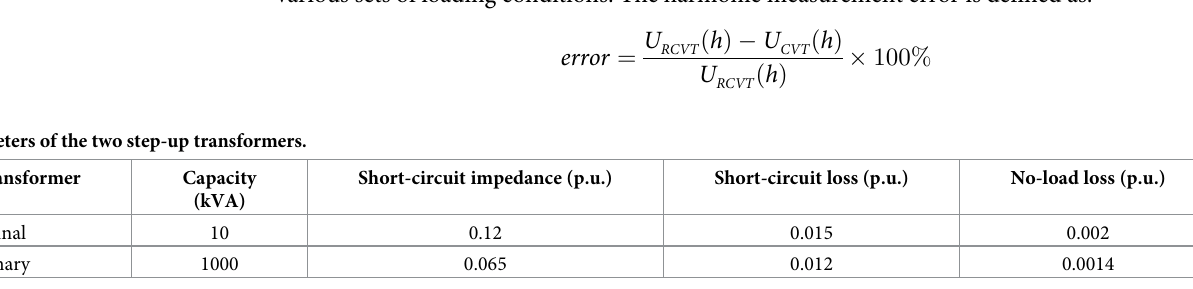
Table 10 lists the experimental results with respect to the secondary side of the CVT obtained under the 100%+1 loading condition. Fig 13 shows the harmonic measurement error under various sets of loading conditions. The harmonic measurement error is defined as: